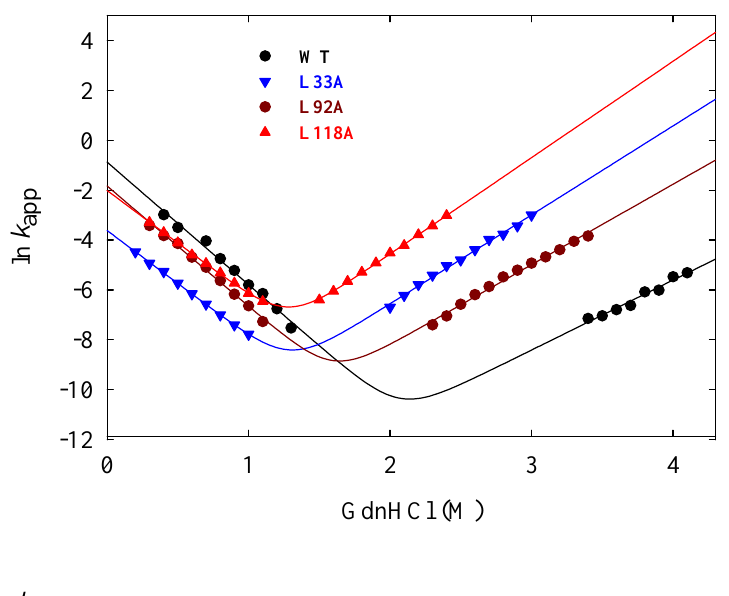
Figure 7. GdnHCl concentration dependence of the logarithm of the apparent rate constant ) for the unfolding and refolding kinetics of the wild-type and three mutant proteins of ( k app Tk-RNase HII at 50 °C. The solid line represents the theoretical curve using Equation (3). Figure is reproduced from